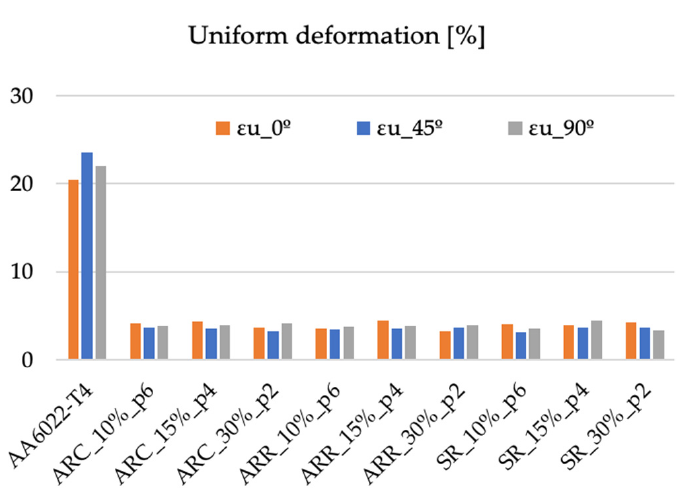
Figure 8. Evolution of uniform deformation with rolling conditions.